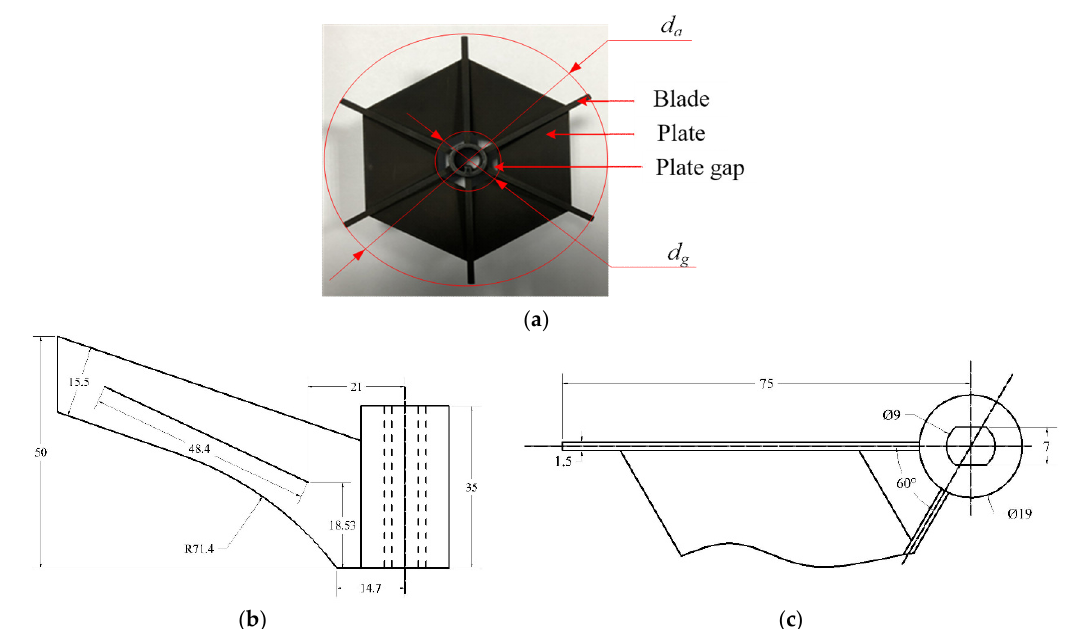
Figure 1. Photo and parameters of the impeller. ( a ) The photo of the impeller; ( b ) The side view of the impeller; ( c ) The top view of the impeller.